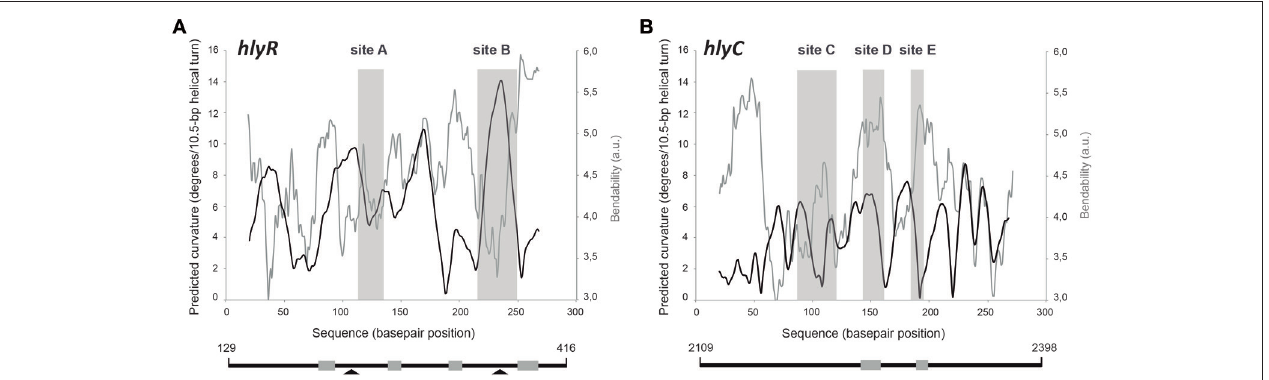
FIGURE 4 | Bendability/curvature propensity plots of the hlyR and hlyC DNA fragments according to the bend.it program (Vlahovicek et al., 2003). The sites recognized preferentially by Mga Spn -His on (A) the 288-bp hlyR DNA fragment (site A, site B), and (B) the 290-bp hlyC DNA fragment (site C, site D, and site E) are shown (gray rectangles). Lines below the plots represent the hlyR and hlyC DNA fragments. Coordinates of both DNA fragments are indicated. Gray boxes show regions of bendability that are either flanking or included into the Mga Spn -His binding sites. Arrowheads indicate peaks of sequence-dependent curvatures on the hlyR DNA